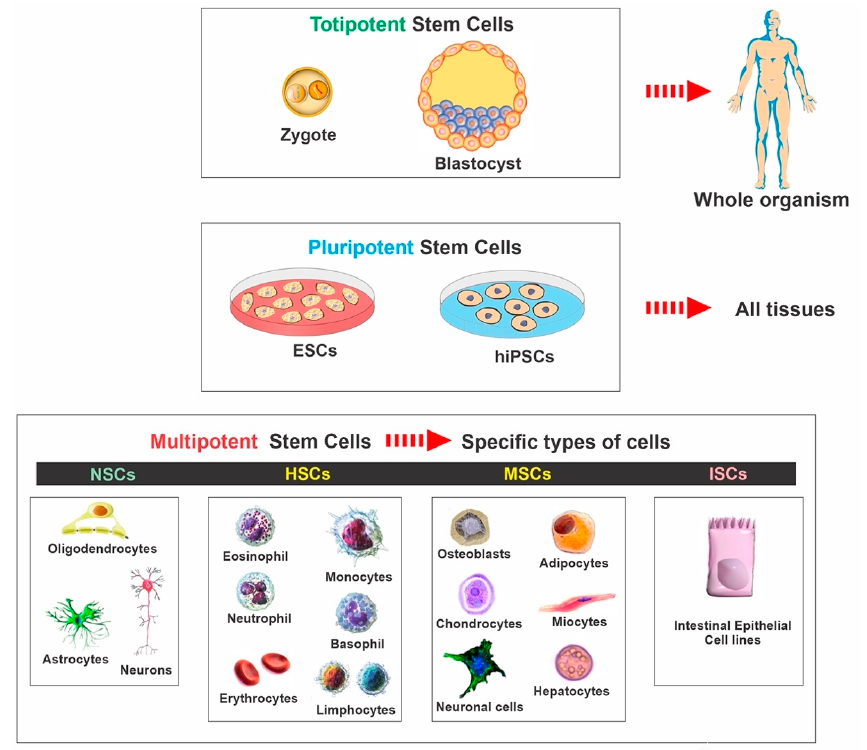
Figure 1. Classification of stem cells: ESCs—embryonic stem cells, hiPSCs—human induced pluripotent stem cells, NSCs—neural stem cells, HSCs—hematopoietic stem cells, MSCs—mesenchymal stem cells, ISCs—intestinal stem cells. Table 1. Comparison between the various types of stem cells. This side-by-side comparison in- cludes their origin and the inherent clinical advantages and disadvantages of using these cells.